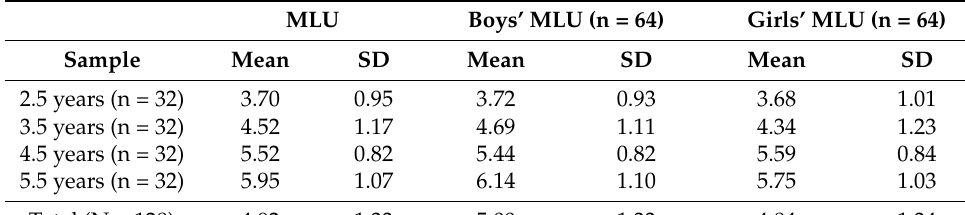
Table 2. Means and standard deviations for the subsample (N = 128).